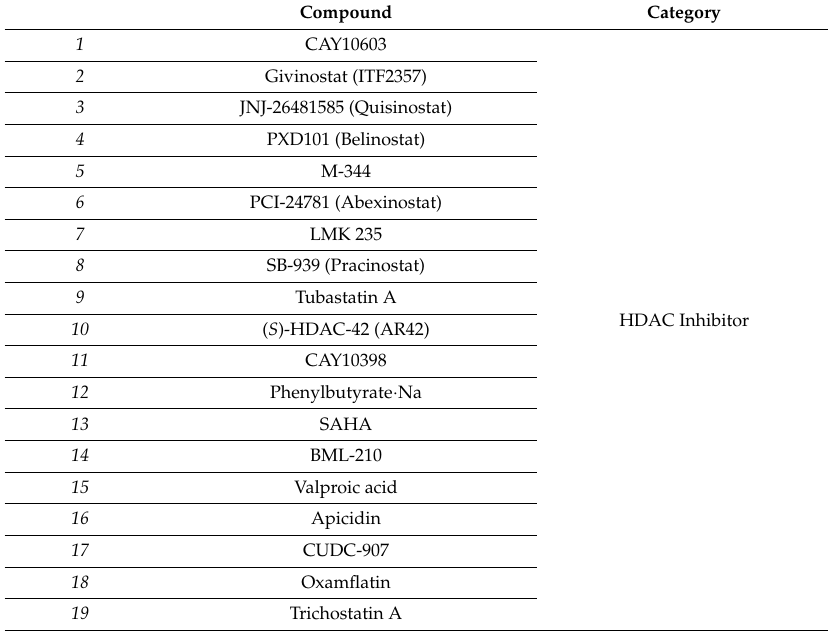
Figure 2. Donut charts demonstrating the BDNF effectors categorized according to their molecular function. ( A ) In HNPCs HDAC inhibitors by having 42% (28 of 67 compounds) are the most notable group. Methyltransferase inhibitors are the second most notable category by having 21% (14 of 67 compounds). ( B ) In fibroblasts, the most notable group is HDAC inhibitors, having 44% (25 of 57 compounds). Histone demethylase inhibitors and bromodomain inhibitors are the second most notable categories by having 12% (each with 7 out of 57 compounds). ( C ) Common compounds between HNPCs and fibroblasts affecting BDNF mRNA transcription. HDAC inhibitors by having 19 of 26 compounds had the highest rank among various categories studied. The second rank belongs to methyltransferase inhibitors and PARP-1 inhibitors each with 2 compounds. Table 1. Common compounds activating BDNF mRNA expression in both human neural progenitor cells and